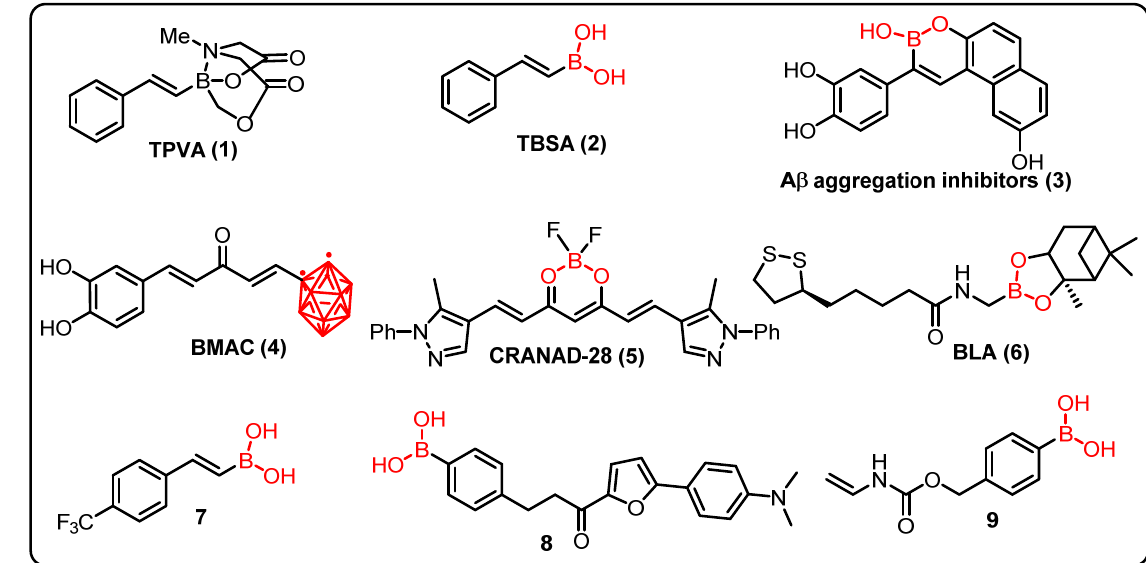
Figure 7. Boron containing an active compound in